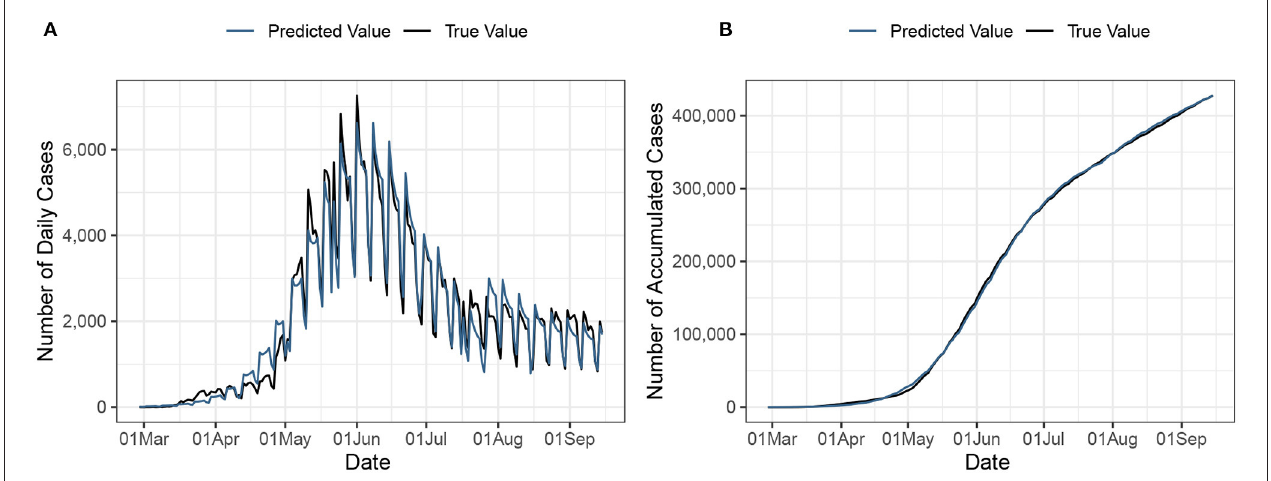
FIGURE 1 | (A) Daily count of confirmed COVID-19 cases in Chile. (B) Cumulative count of COVID-19 cases in